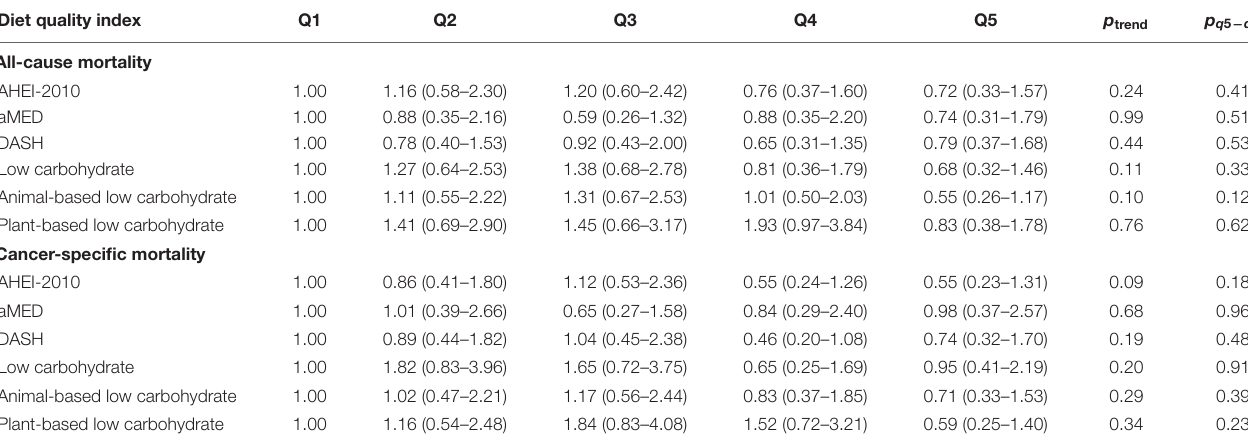
TABLE 5 | HRs † and 95% CIs for all-cause and cancer-specific mortality from traditional Cox Proportional Hazards Models (Cox PH) examining baseline index values only and employing administrative right-censoring at 3 years after diagnosis. Diet quality